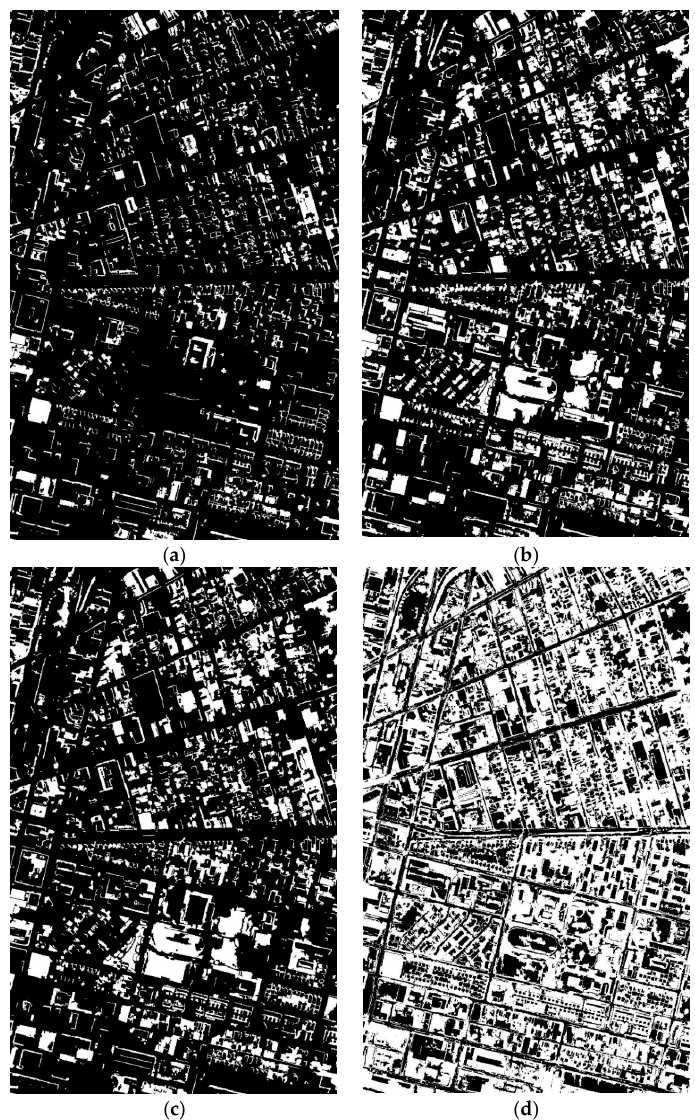
Figure 13. Binary change maps by OTSU of ( a ) supervised MAD, ( b ) unsupervised MAD, ( c ) stack PCA, and ( d ) the binary change maps of post-classification, where the changed areas are white and the unchanged areas are black.